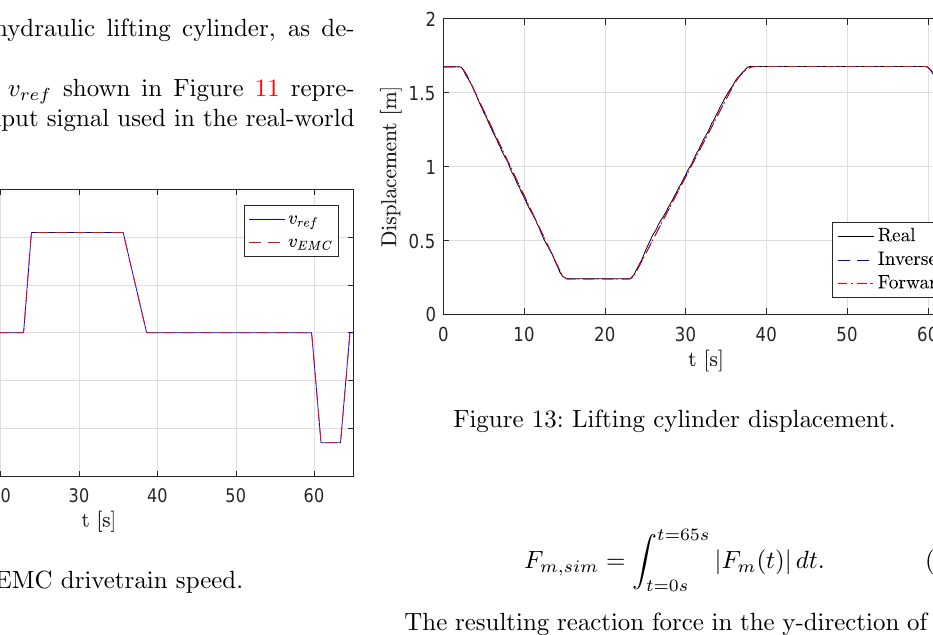
The resulting reaction force in the y-direction of the longitudinal driver constraint is derived from Equa- tion 10 and shown in Figure 14.